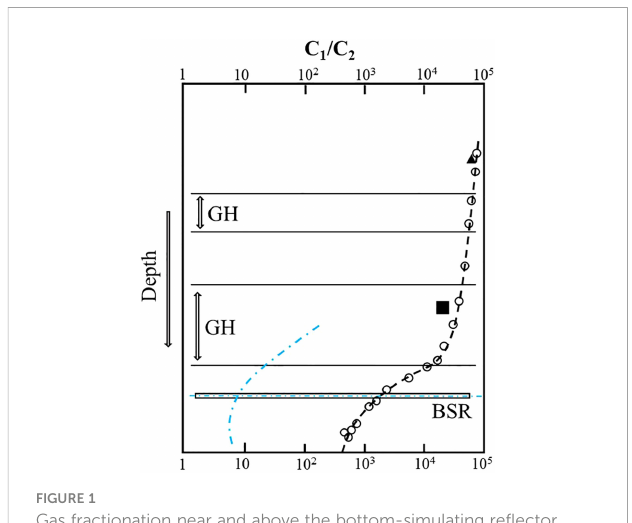
FIGURE 1 Gas fractionation near and above the bottom-simulating re fl ector (BSR). C 1 /C 2 ratio in gas voids (open circles) and PCS gases (black triangles) and C 1 /C 2 ratio in hydrates at sites 1,247, ODP Leg 204 (Milkov et al., 2004); blue indicates C 1 /C 2 ratio in gas voids at NW Borneo (Paganoni et al.,